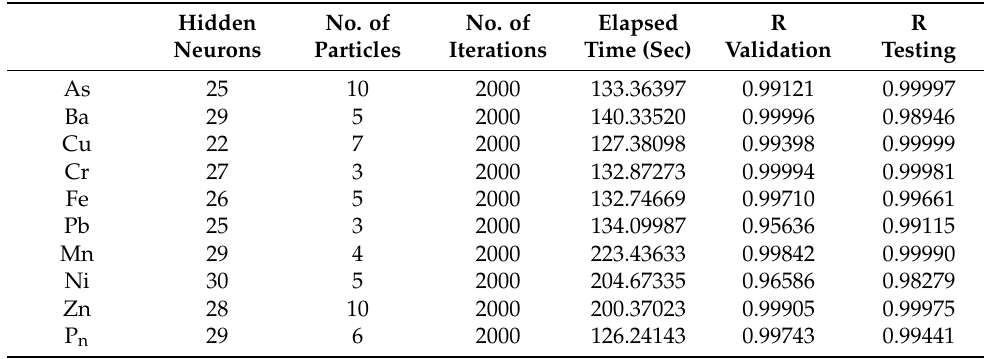
Table 5. NN-PSO Simulation Results for Sediment